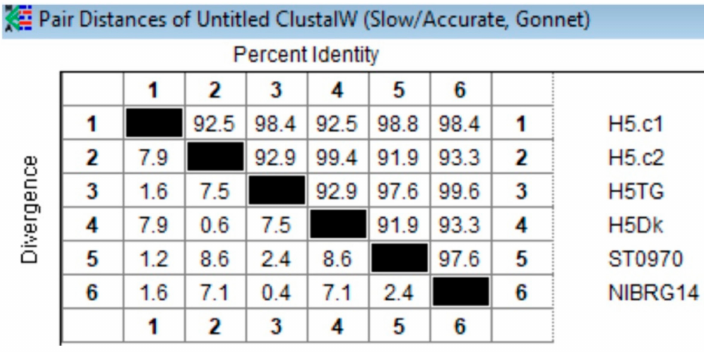
Figure A3. Amino acid sequence identity percentage of HA